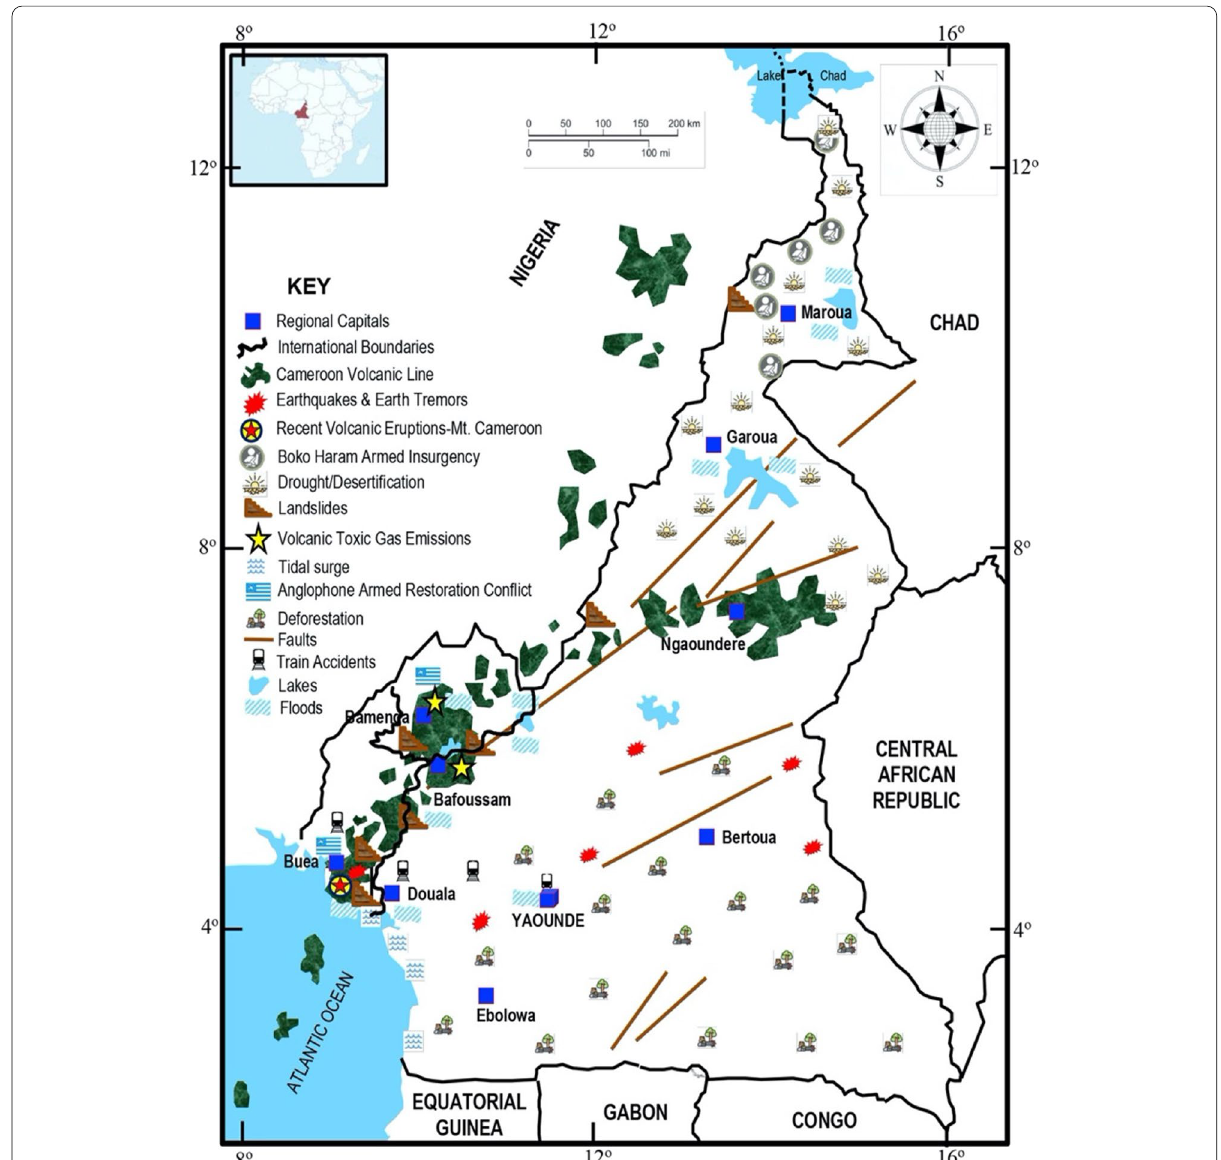
Fig. 1 Map of Cameroon showing the Anglophone regions including the main natural hazards in the country. Source: Bang